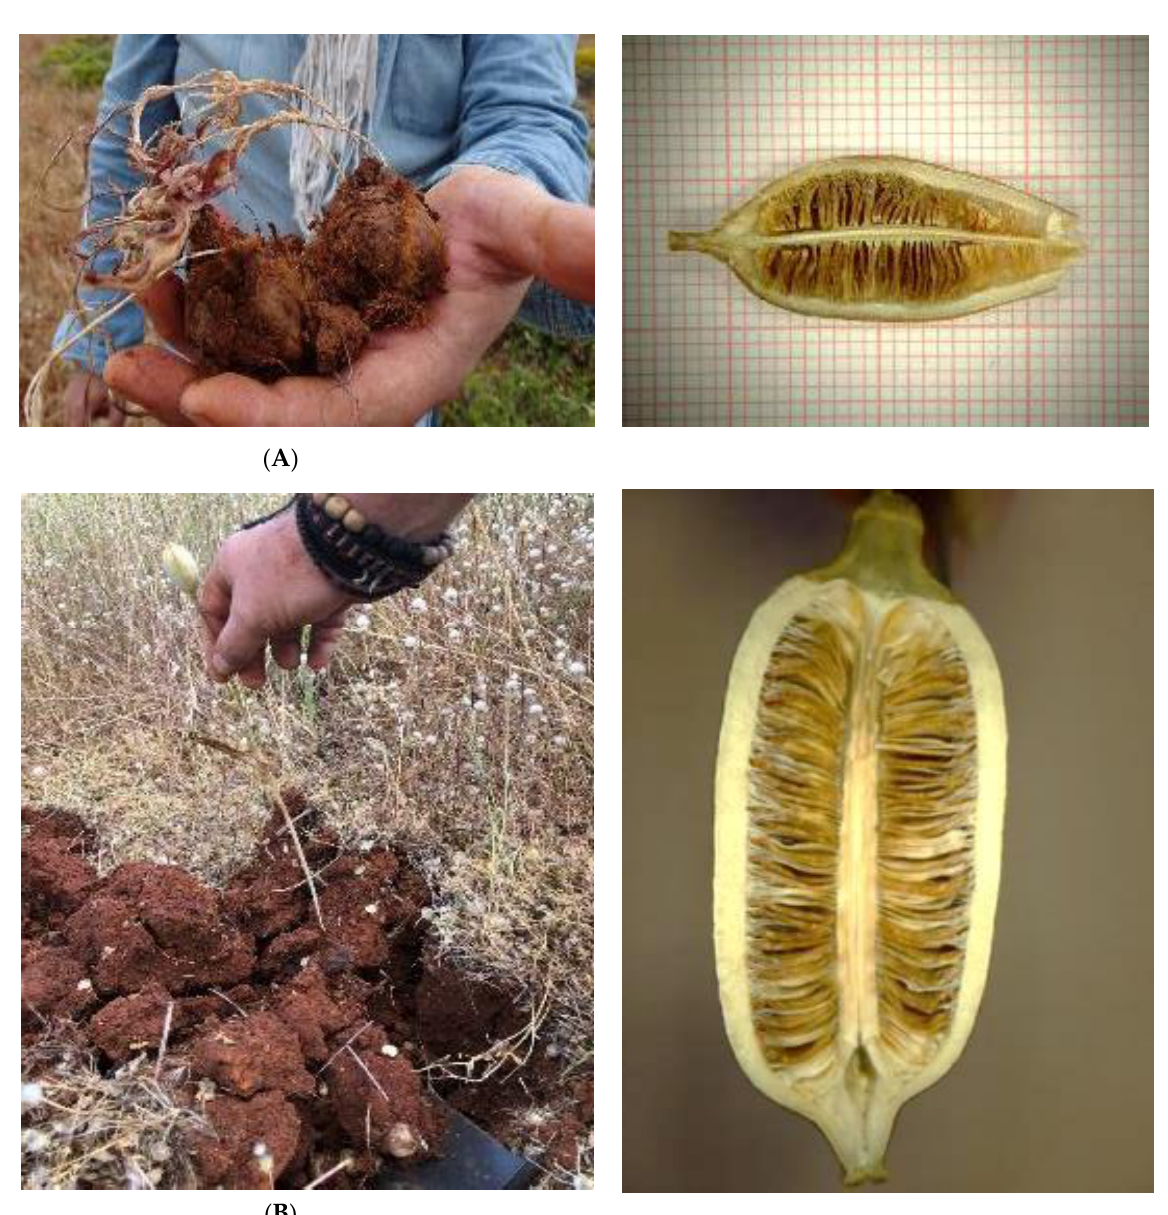
Figure 3. ( A ) Wild-growing individuals of the Mediterranean Tulipa australis at the summit area of Mt Vermion, Northern Greece; ( B ) underground individual bulb; and ( C ) repatriated well-documented bulbs of the same species from the Gothenburg Botanical Garden, Sweden that were originally collected close to the summit area of Mt Vourinos, northern Greece in 2001.